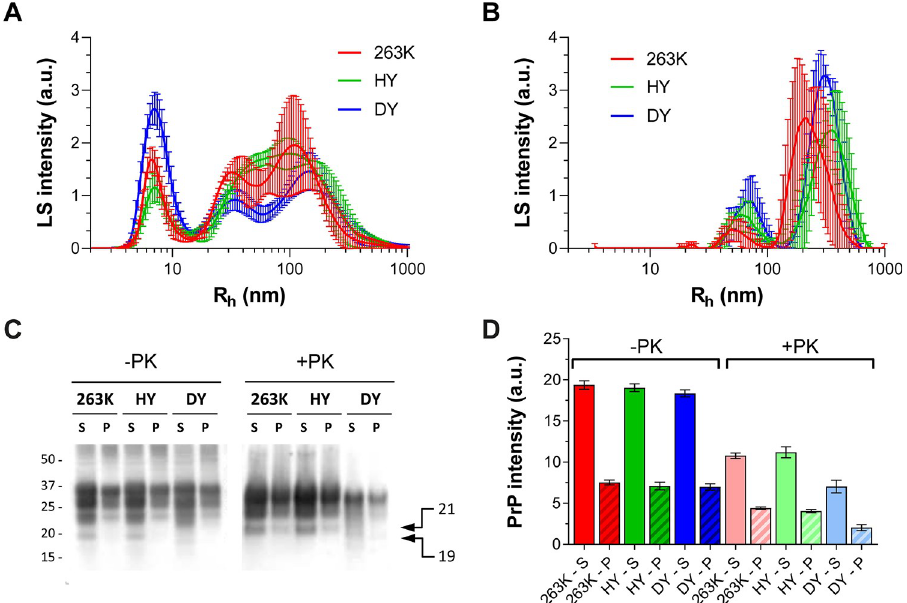
Fig 1. Particle size distributions determined by DLS measurements of detergent-soluble ( A ) and pellet ( B ) fractions after sequential incubation of 263K (red), HY (green), and DY (blue) brain homogenates with 2% dodecyl- β -maltoside and 2% sarkosyl, followed by 10 min centrifugation at 20,000 x g. Representative immunoblotting ( C ) and densitometric analysis ( D ) of detergent-soluble (S) and pellet (P) fractions of 263K (red), HY (green) and DY (blue). The pellet was resuspended in half of the original volume; the same volumes of S and resuspended P fractions were loaded in the polyacrylamide gel. Twice the volume of PK treated samples (20 μ g/mL of PK for 1h at 37˚C) were loaded in the same gel for quantification. SAF83 (dilution 1:10,000) was used as primary antibody. Bars represent average ± SE of three BHs for each prion